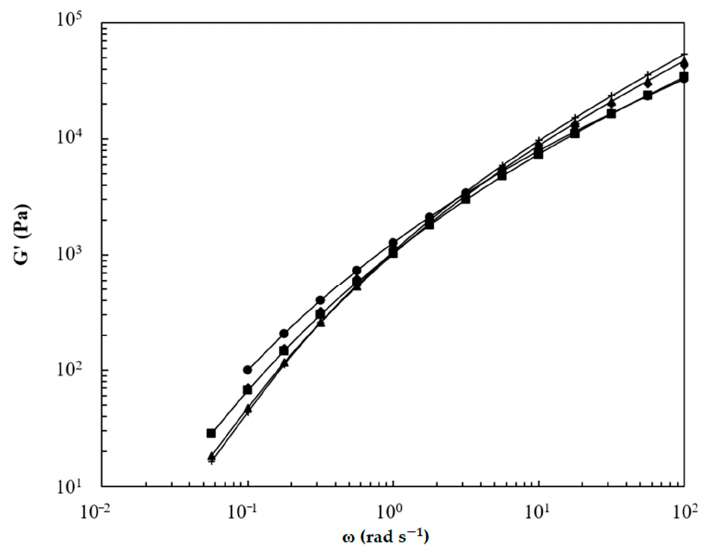
Figure 5. Storage modulus of BPBS (•), LPBS (+), and BPBS/LPBS blends ( ■ ) 80/20%, ( ◆ ) 50/50%, ( ▲ ) 20/80% at 150 °C.